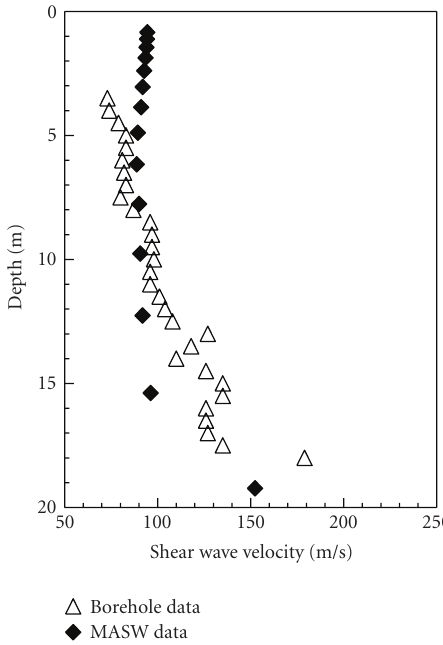
Figure 7: Sample shot gather from the MASW method for the NRC site.